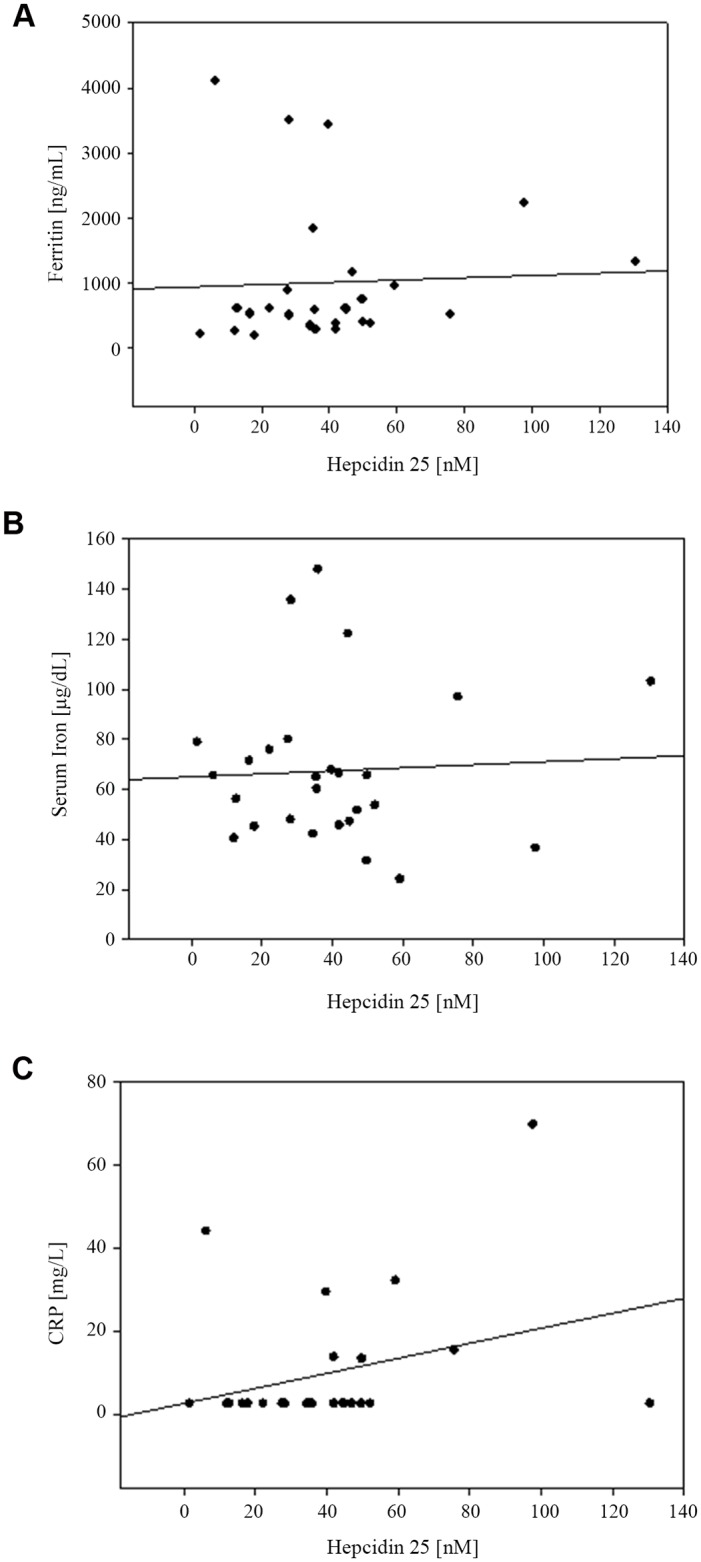
Scatter Plot.Correlation in HD patients between A. ferritin and Hep-25 (r = 0.04; P = 0.82); B. serum iron and Hep-25 (r = 0.05; P = 0.79); and C. CRP and Hep-25 (r = 0.31; P = 0.12).